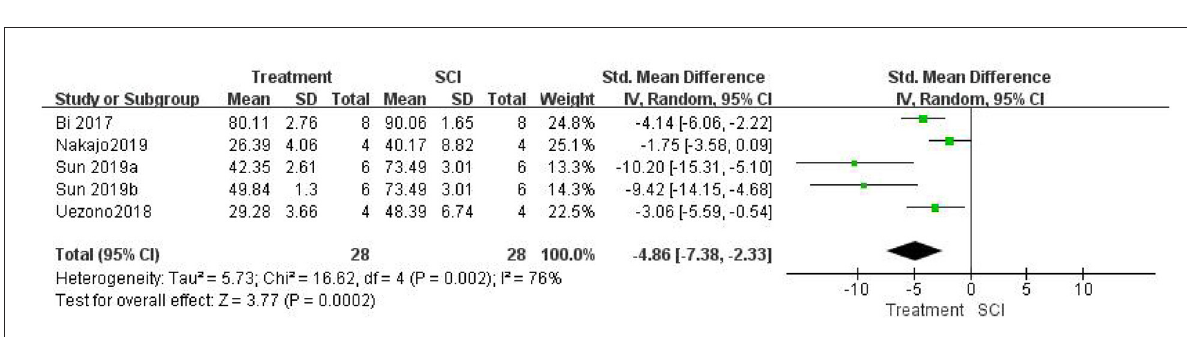
FIGURE6 Forest plot for the effects of HMGB1 intervention on spinal cord water content in SCI (random-effects